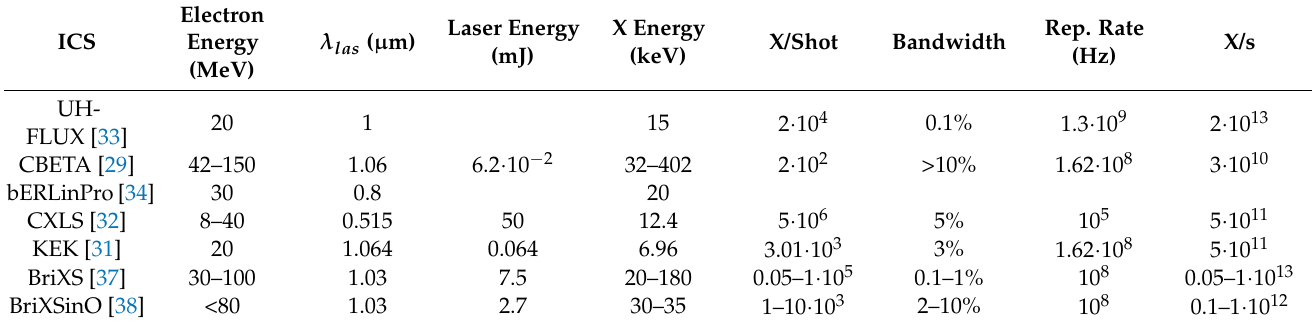
Table 3. ERL +laser in cavity. All data are estimated, apart the KEK data, that are